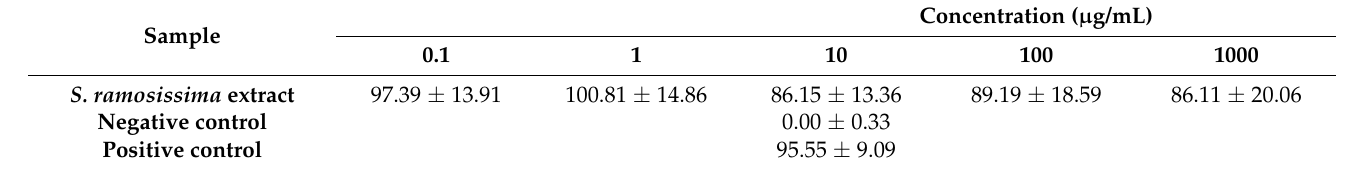
Table 4. Effects of the best S. ramosissima extract exposure on the viability (%) of HFF-1 cell line at different concentrations, as measured by the MTT assay. Values are expressed as mean ± standard deviation ( n = 3).